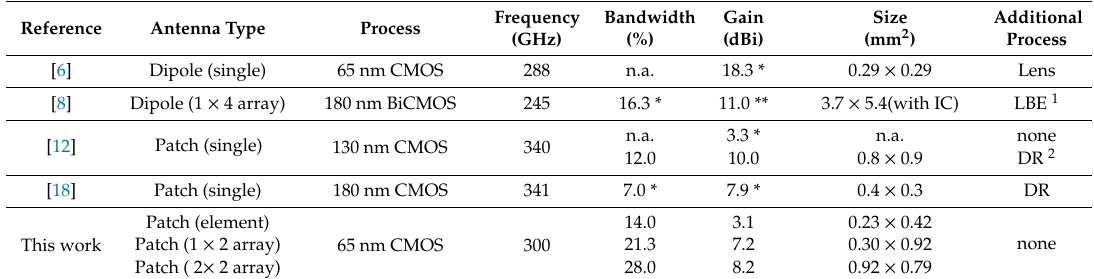
Table 2. Comparison of the reported THz CMOS on-chip antenna.